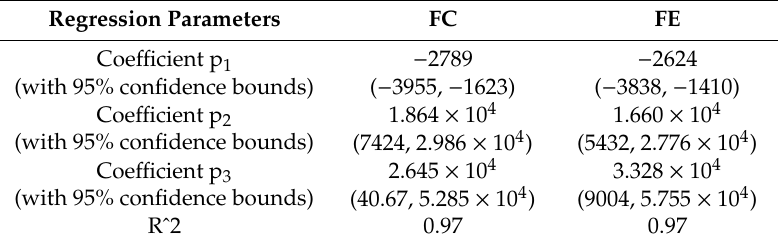
Figure A4. NTR-v regression curves(E1)obtained from the field tests performed in 8th gear in FC and FE configurations. Table A2. Regression parameters for the NTR-v relationship in 8th gear.